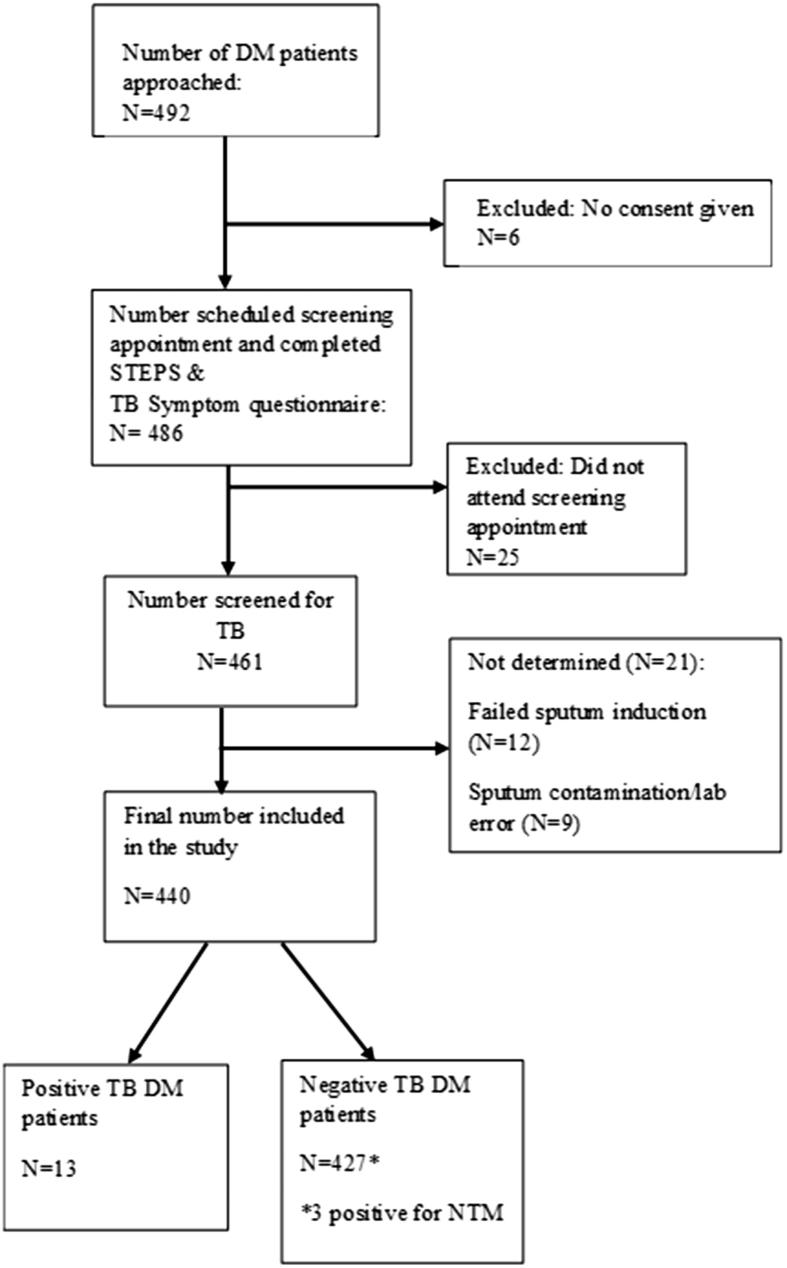
Flowchart of recruitment process and results of screening DM patients for TB attending a DM clinic at Khayelitsha (Site B) Community Health Clinic from September 2014 to October 2015. DM = diabetes mellitus; TB = tuberculosis.